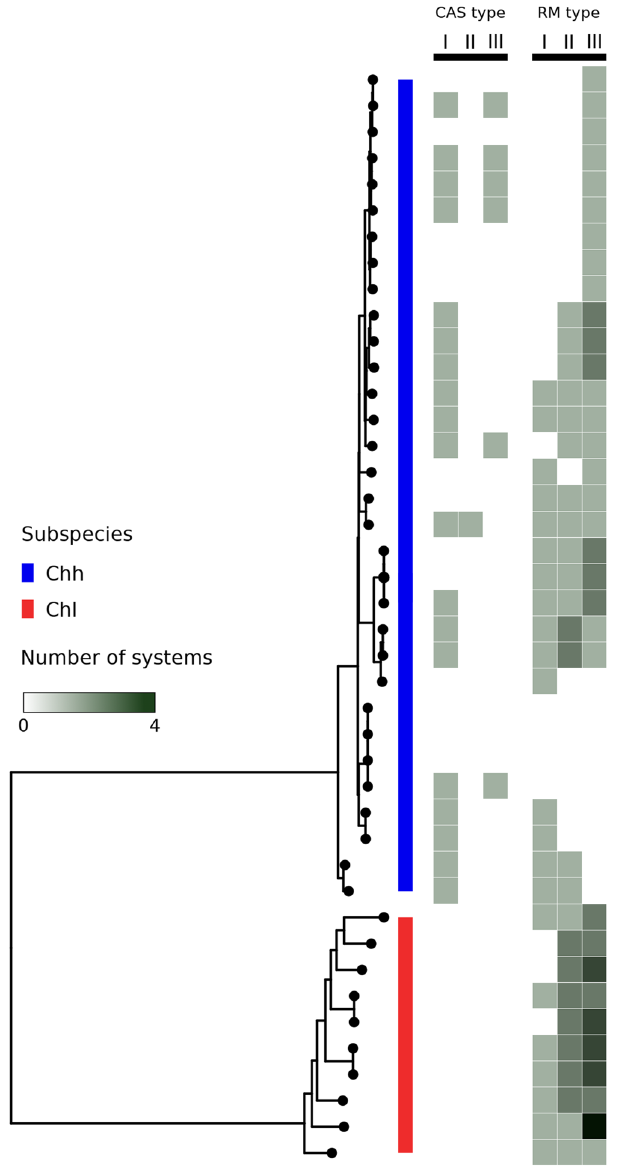
Figure 4. Different repertories of CRISPR/Cas proteins and R-M systems between subspecies. Phylogenetic tree of C. hyointestinalis subspecies annotated with information CRISPR/Cas systems and R-M systems. Vertical strips in the right side are colored according to copy number of complete CRISPR/Cas and R-M systems classified by type. Detailed information about copy number is provided in Table